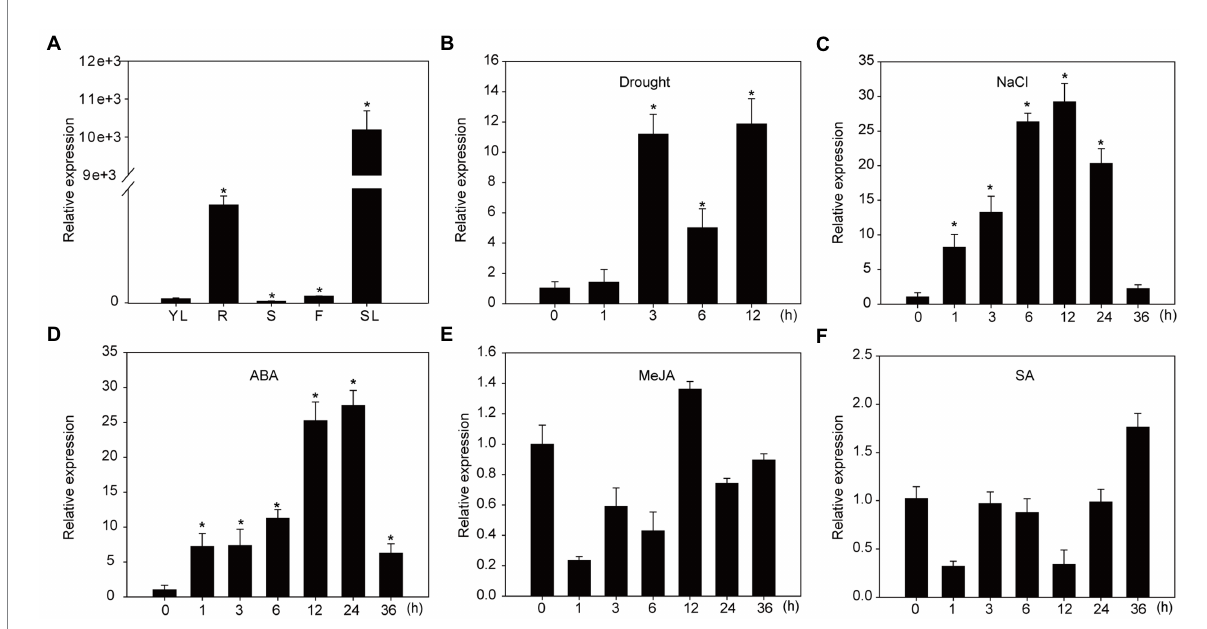
FIGURE 1 Expression profiling of NtNAC028 . (A) The expression pattern of NtNAC028 in various organs of tobacco plants (K326). YL, young leaf; R, root; S, stem; F, flower; SL, senescence leaf. (B,C) NtNAC028 expression in response to different stress conditions. (D–F) The expression pattern of NtNAC028 under exogenous phytohormone treatments. ABA, abscisic acid; JA, jasmonic acid; and SA, salicylic acid. The bars are SD of three biological replicates. Asterisks indicate significant difference by Student’s t -test (* p <